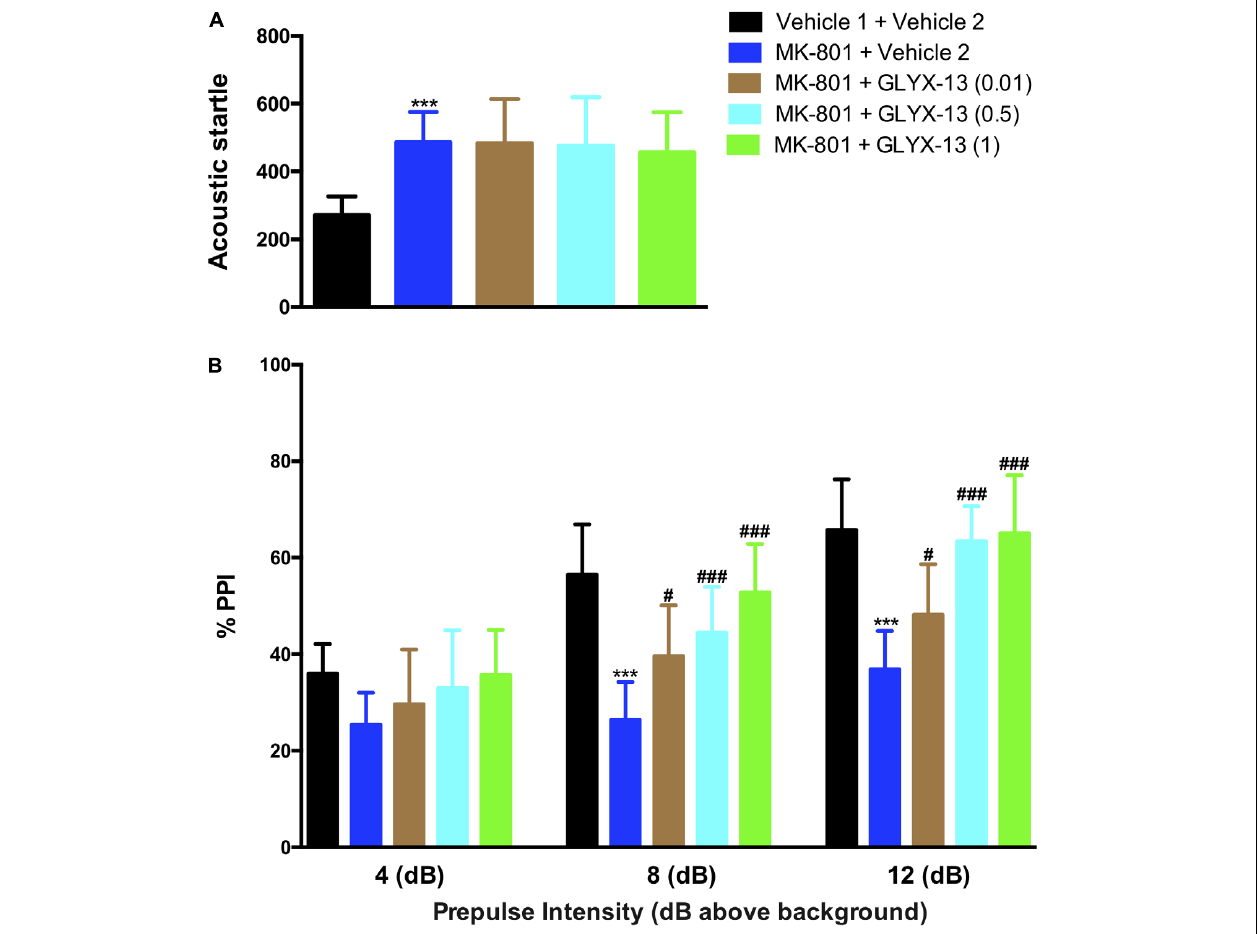
FIGURE 3 | GLYX-13 significantly attenuated MK-801-induced impairments in PPI but not the startle response. (A) MK-801 significantly increased the startle amplitude. (B) Effect of GLYX-13 on PPI inhibition of the startle response at different prepulses (4, 8, and 12 dB above background) presented before the startle pulse intensity (120 dB). Data represent the mean ± SEM ( n = 12 per group; ∗∗∗ P < 0.001, versus the vehicle 1 + vehicle 2-treated group; # P < 0.05 and ### P < 0.001, versus the MK-801 + vehicle 2-treated